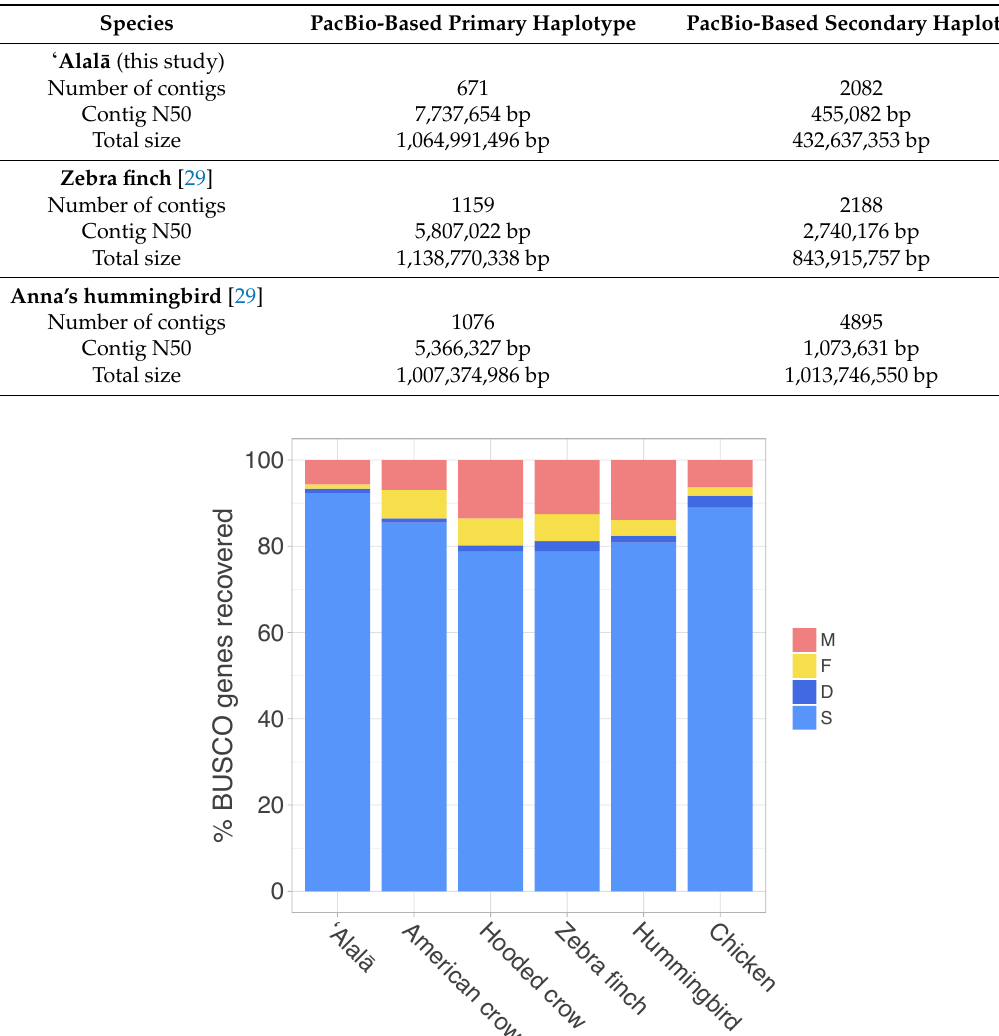
Figure 1. Genome assembly completeness assessed by the recovery of universal single-copy genes (BUSCOs). Percentages refer to complete genes that were found as single (S) or multiple copies (D), as well as fragmented (F) and missing (M) genes. Analyses were based on the BUSCO eukaryote dataset ( n = 303